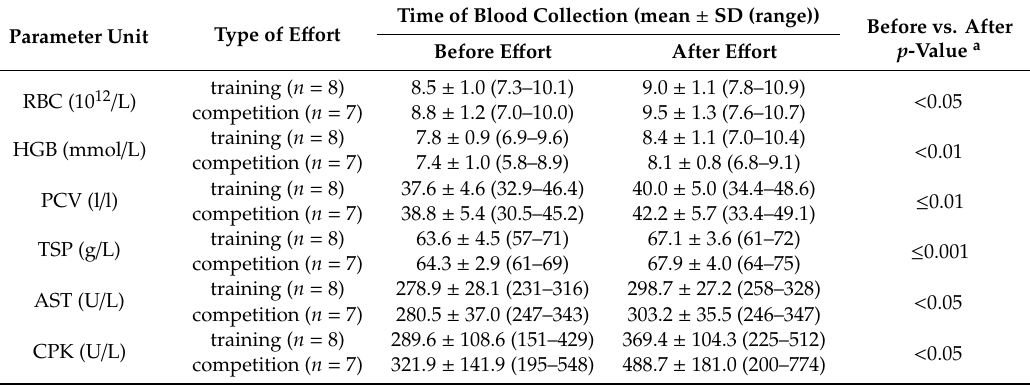
Table 3. Other hematological and serum biochemical parameters before and after the e ff ort (training and